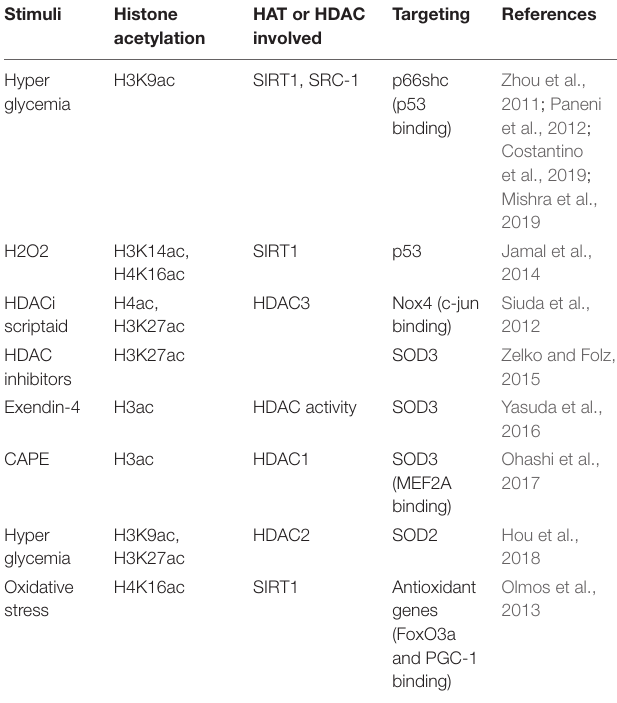
TABLE 3 | Histone acetylation involved in endothelial mediated oxidative